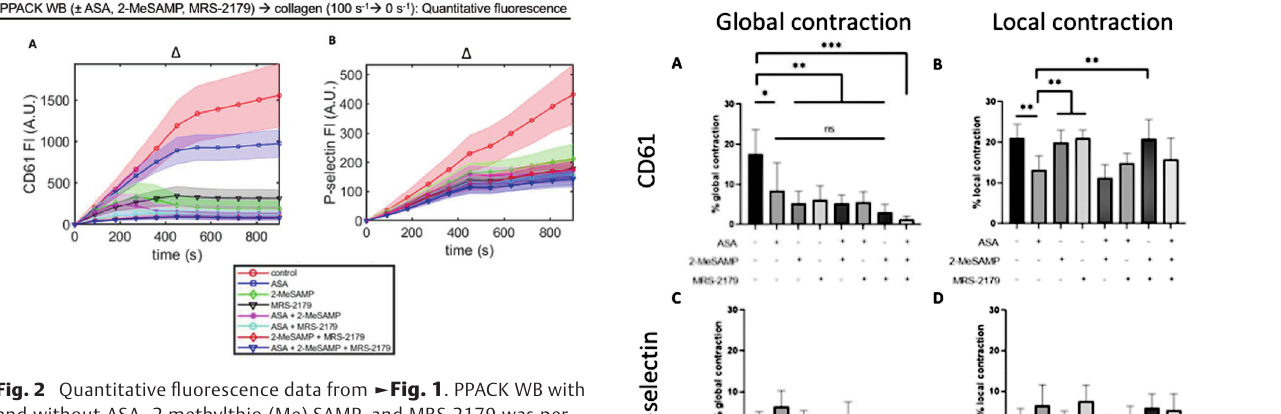
TH Open Vol. 00 No. 0/2022 © 2022. The